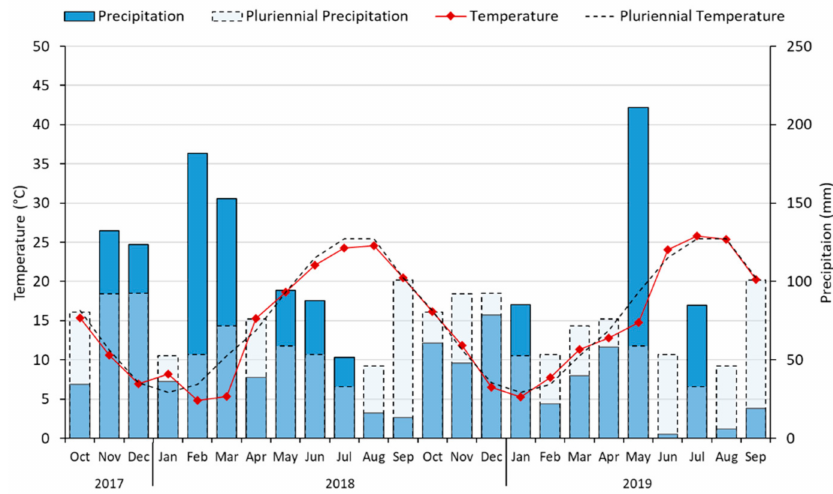
Figure 1. Monthly mean precipitation and air temperatures for the study area during the